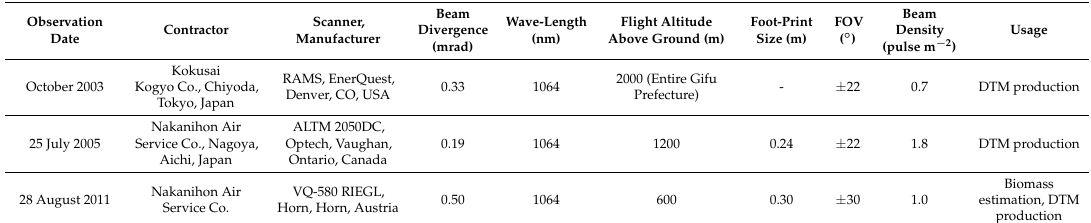
Table 2. Summary of LiDAR observations.